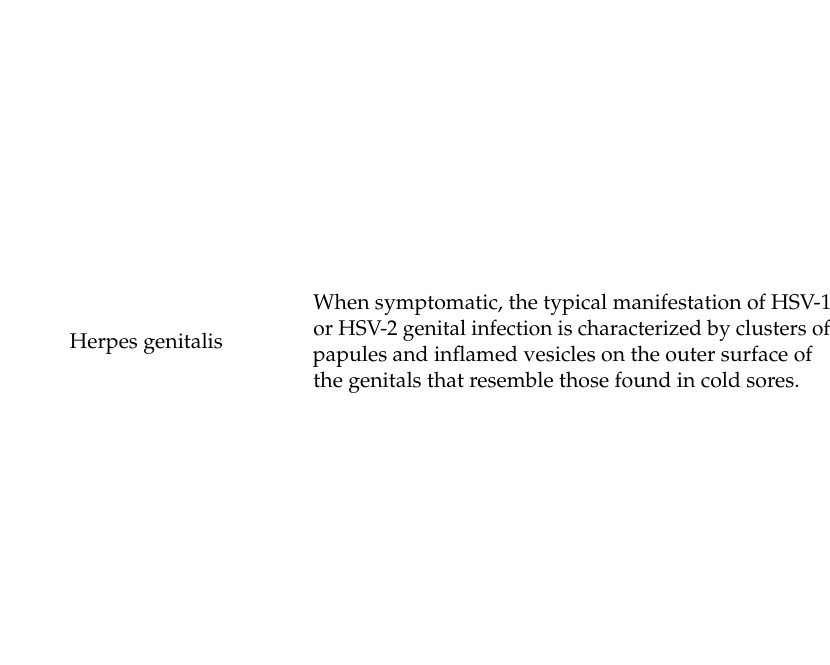
Figure 3. Herpes genitalis manifestations, licence CC BY-SA 3.0, adapted for gentle concession of SOA-AIDS